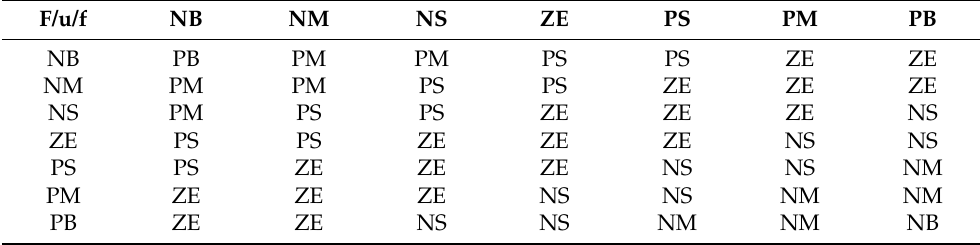
The MR damping clamp parameter fuzzy–PID vibration control system was estab- lished in MATLAB/Simulink software, as shown in Figure 8.